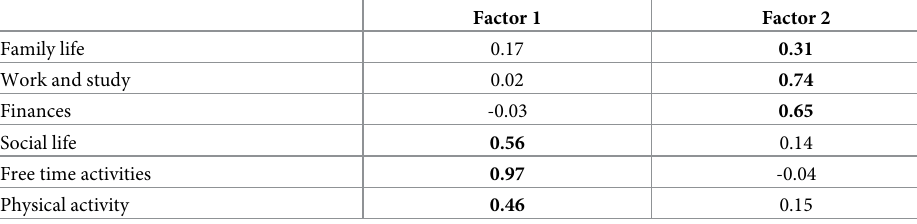
Table 3. Factor loadings of self-reported COVID-19